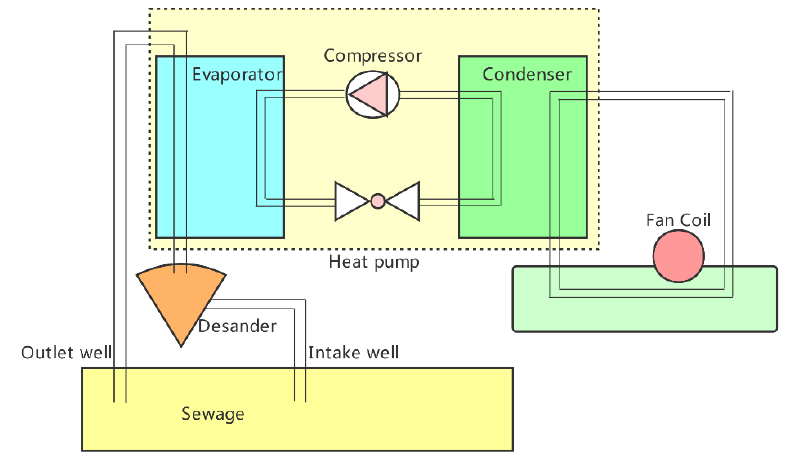
Figure 2. Common structure chart of the wastewater source heat pump Figure 2. C ommon structure chart of the wastewater source heat pump (WWSHP).